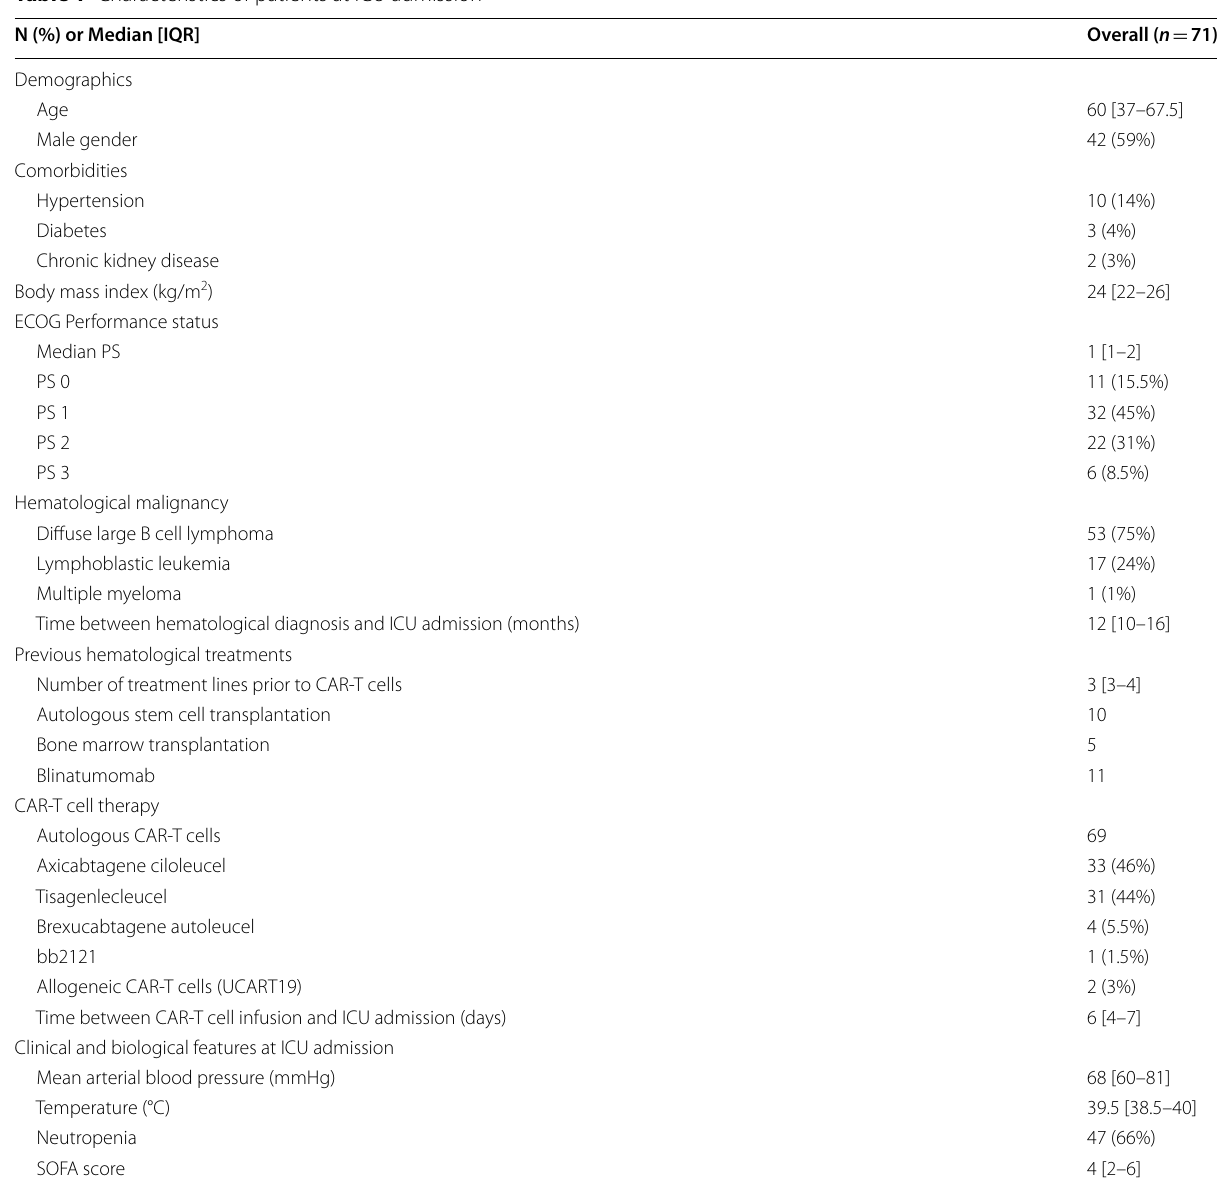
Table 1 Characteristics of patients at ICU